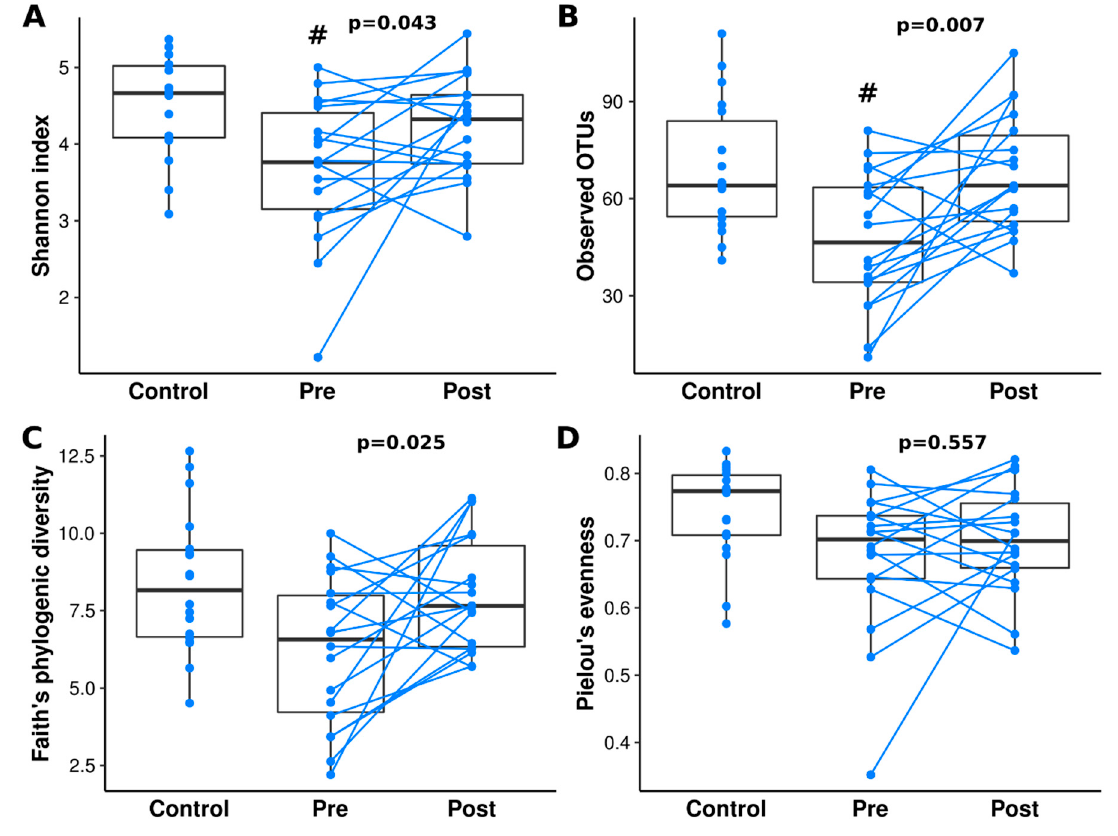
Figure 1. Differences in alpha diversity analysis of control and patients with CD (Crohn’s disease) pre- and post-IFX therapy. Alpha diversity was measured by the Shannon index ( A ), observed OTUs ( B ), Faith’s phylogenetic diversity ( C ), and Pielou’s measure of species evenness ( D ). Kruskal-Wallis with post-hoc was performed to analyze statistical significance. Statistically significant values, after Benjamini-Hochberg correction, between control and other groups were represented as “#”. Paired t-test p -values are shown above the patients with CD bars. Lines connect paired samples from the same individual.